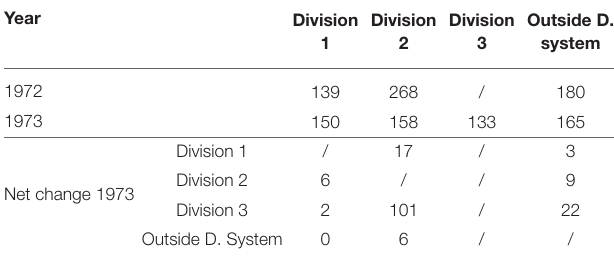
TABLE 1 | Division split up